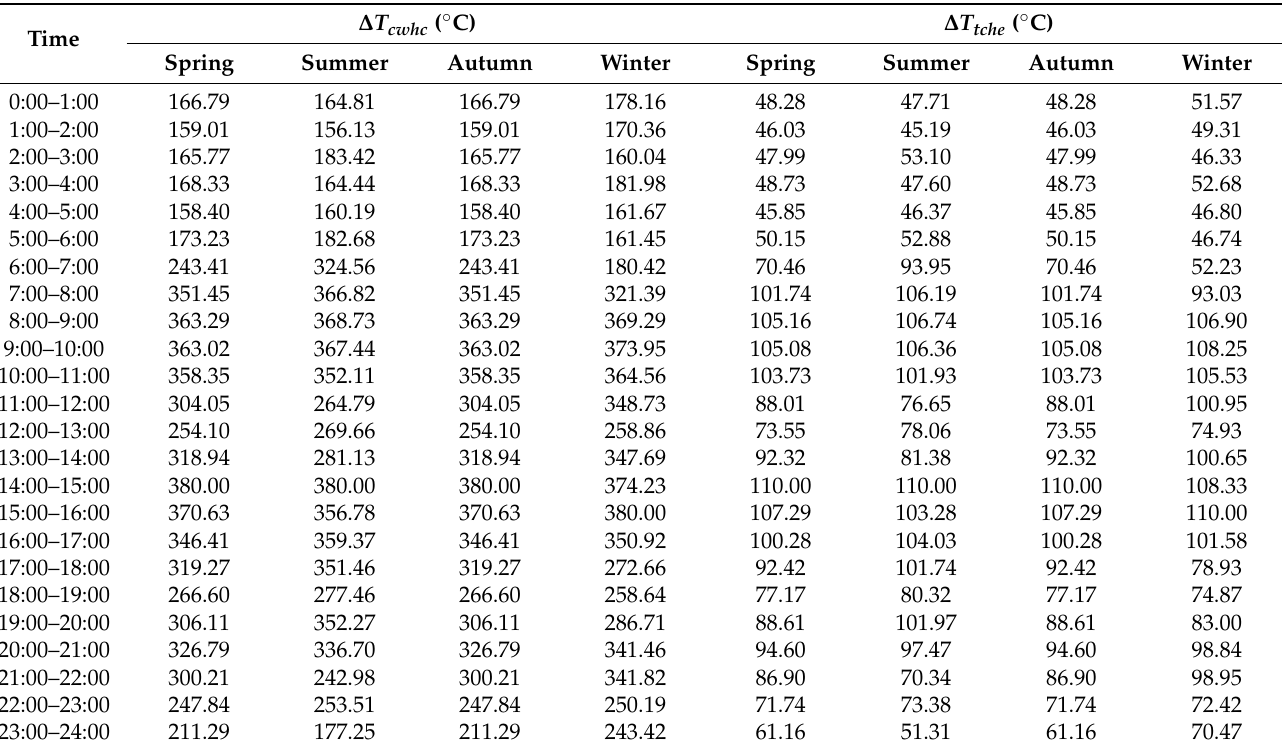
Table A4. Values of time-varying parameters related to low-temperature waste heat in Case